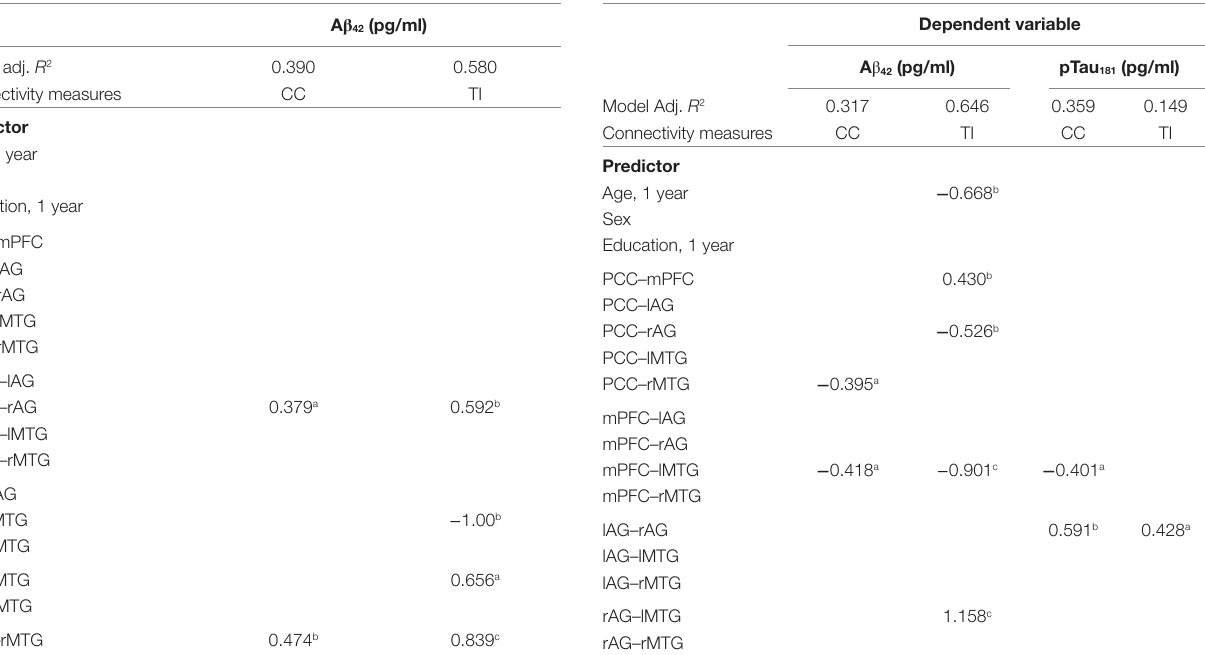
TaBle 2 | standardized beta coefficients for a β 42 models, including resting-state functional connectivity measures [cross-correlation (cc) and total interdependence (Ti)].